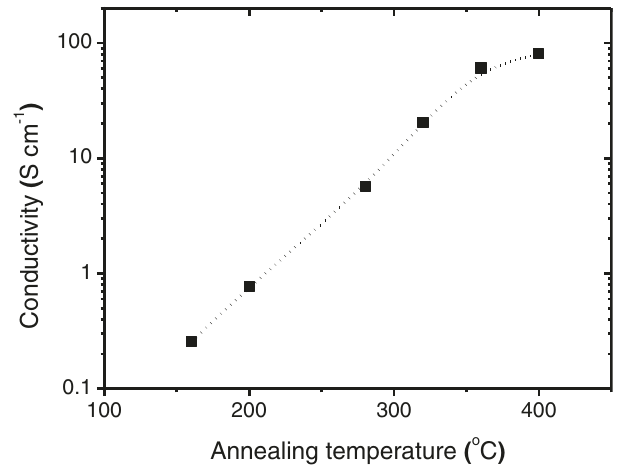
Fig. 3 | Impact of UV treatment on conductivity of the ZnO fi lms annealed at different temperatures. The conductivity of the UV-treated (365nm, 24W, and 600s) ZnO fi lm annealed with a higher temperature is higher than that annealed with a lower